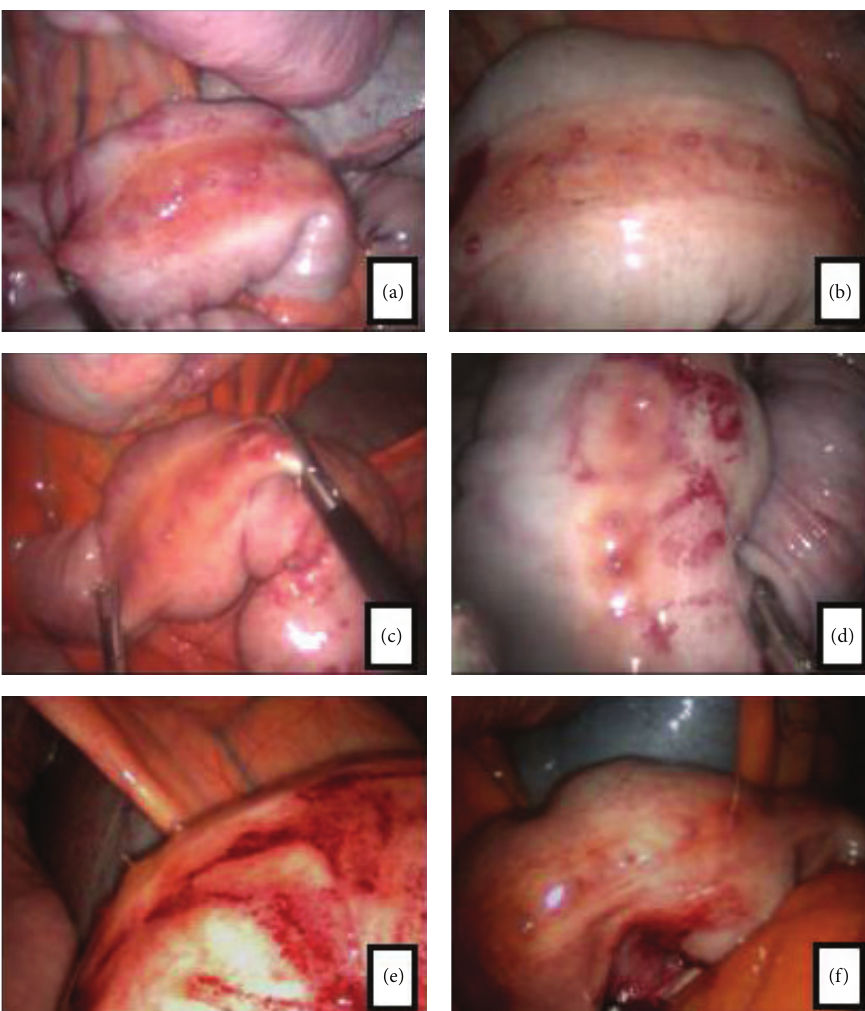
Figure 4: Laparoscopic image of small colon region subjected to enterotomy. (a), (b), and (c) control group (small colon enterotomy region covered by fibrin); (d), (e), and (f) treated group (small colon enterotomy region covered with fibrin; segments presenting hemorrhagic soon after